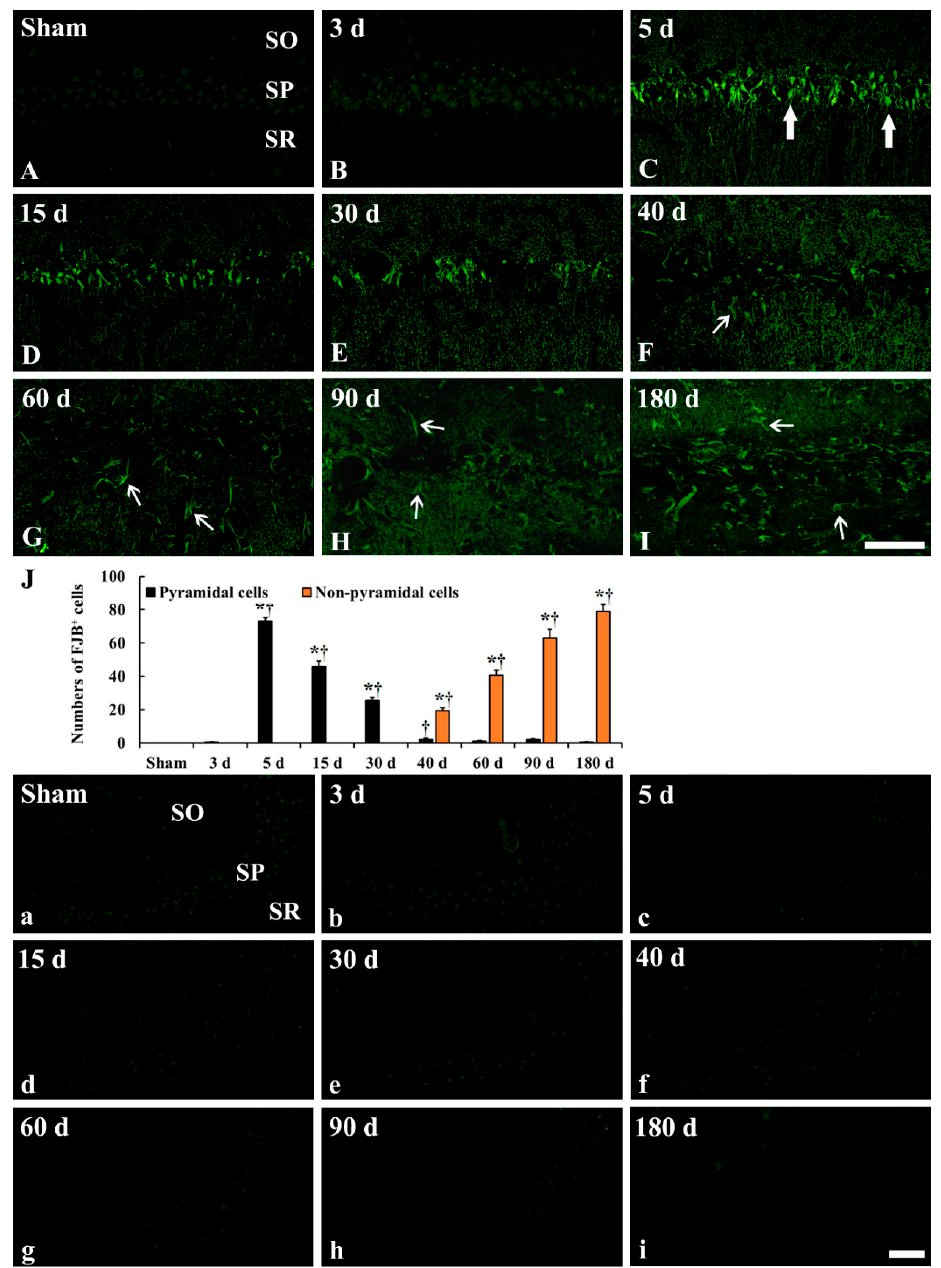
Figure 3. Fluoro-Jade B (FJB) fluorescence staining in the CA1 ( A – I ) and CA2/3 ( a – i ) of the sham operated ( A , a ) and ischemia operated ( B – I , b – i ) groups after tgCI. In the CA1, FJB + pyramidal cells (large arrows) are shown in the stratum pyramidale (SP) from 5 to 30 days after tgCI. In addition, many FJB + cells (small arrows) are detected in the stratum oriens (SO) and radiatum (SR) from 40 to 180 days after tgCI. In the CA2/3, FJB + cells are not shown at any time after tgCI. Scale bar = 50 µ m. ( J ) Numbers of FJB + pyramidal (black) and non-pyramidal (yellow) cells in the CA1 ( n = 7; * p < 0.05 vs. sham operated group, † p < 0.05 vs. pre-time point group). The bars indicate the means ±